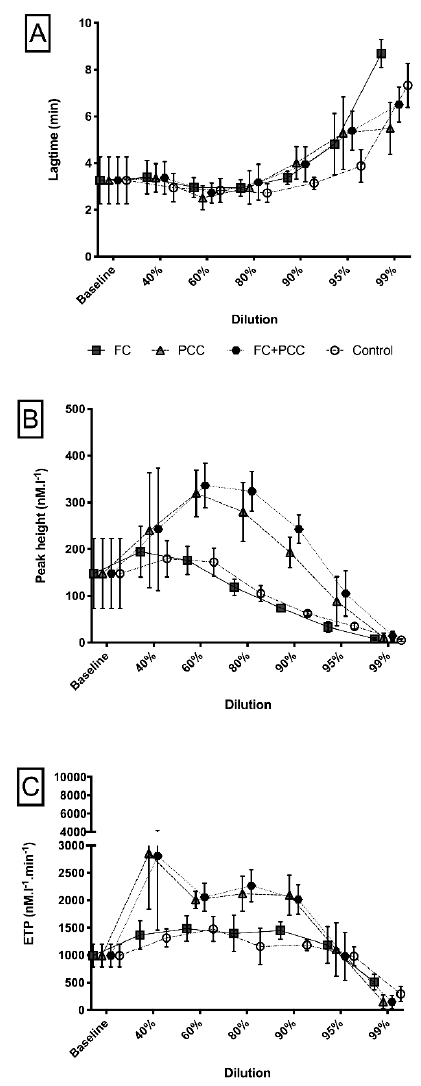
Figure 5. ( A ) Lagtime, ( B ) peak height, and ( C ) endogenous thrombin potential in a comparison between the four study groups and different dilution levels after correction of antithrombin activity to 100%. ( A ) The control group showed significantly shorter time values ( p < 0.05) at the 90% and 95% dilution levels. ( B ) Within the groups containing PCC, FC + PCC showed significantly higher values ( p < 0.05) at the 80% and 90% dilution levels. The groups without PCC (FC, Control) showed significantly lower